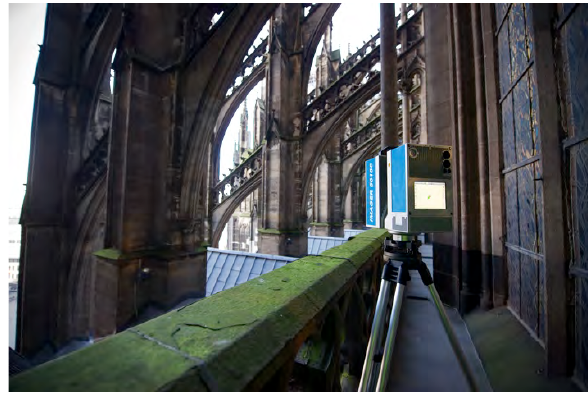
Image 7: Z+F 5010C terrestrial laser scanner, 27m level, Cologne